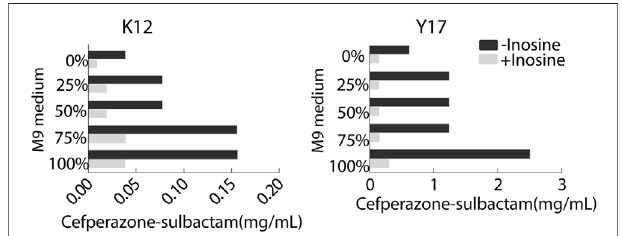
FIGURE 3 | MKC of K12 and Y17 in the presence or absence of 5 mM inosine and different ionic strength by SCF.